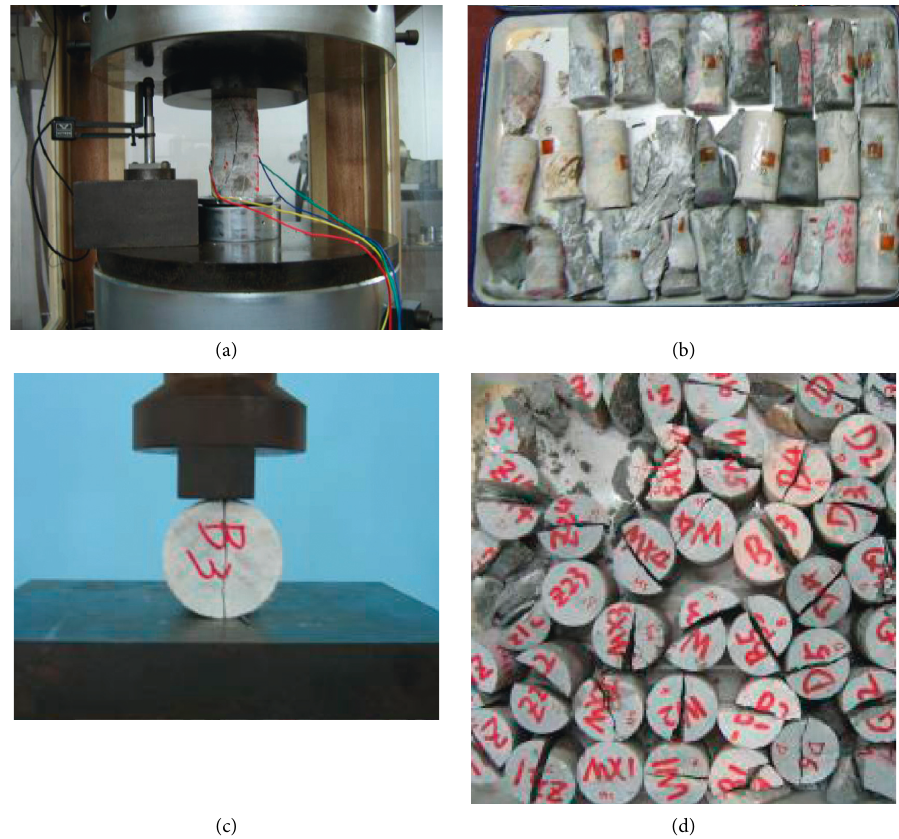
Figure 4: Mechanical property test processes and result for dolomitic limestone. (a) Uniaxial compression test. (b) Brazilian test of rock. (c) Uniaxial compressive failure specimens. (d) Brazilian test failure specimens.